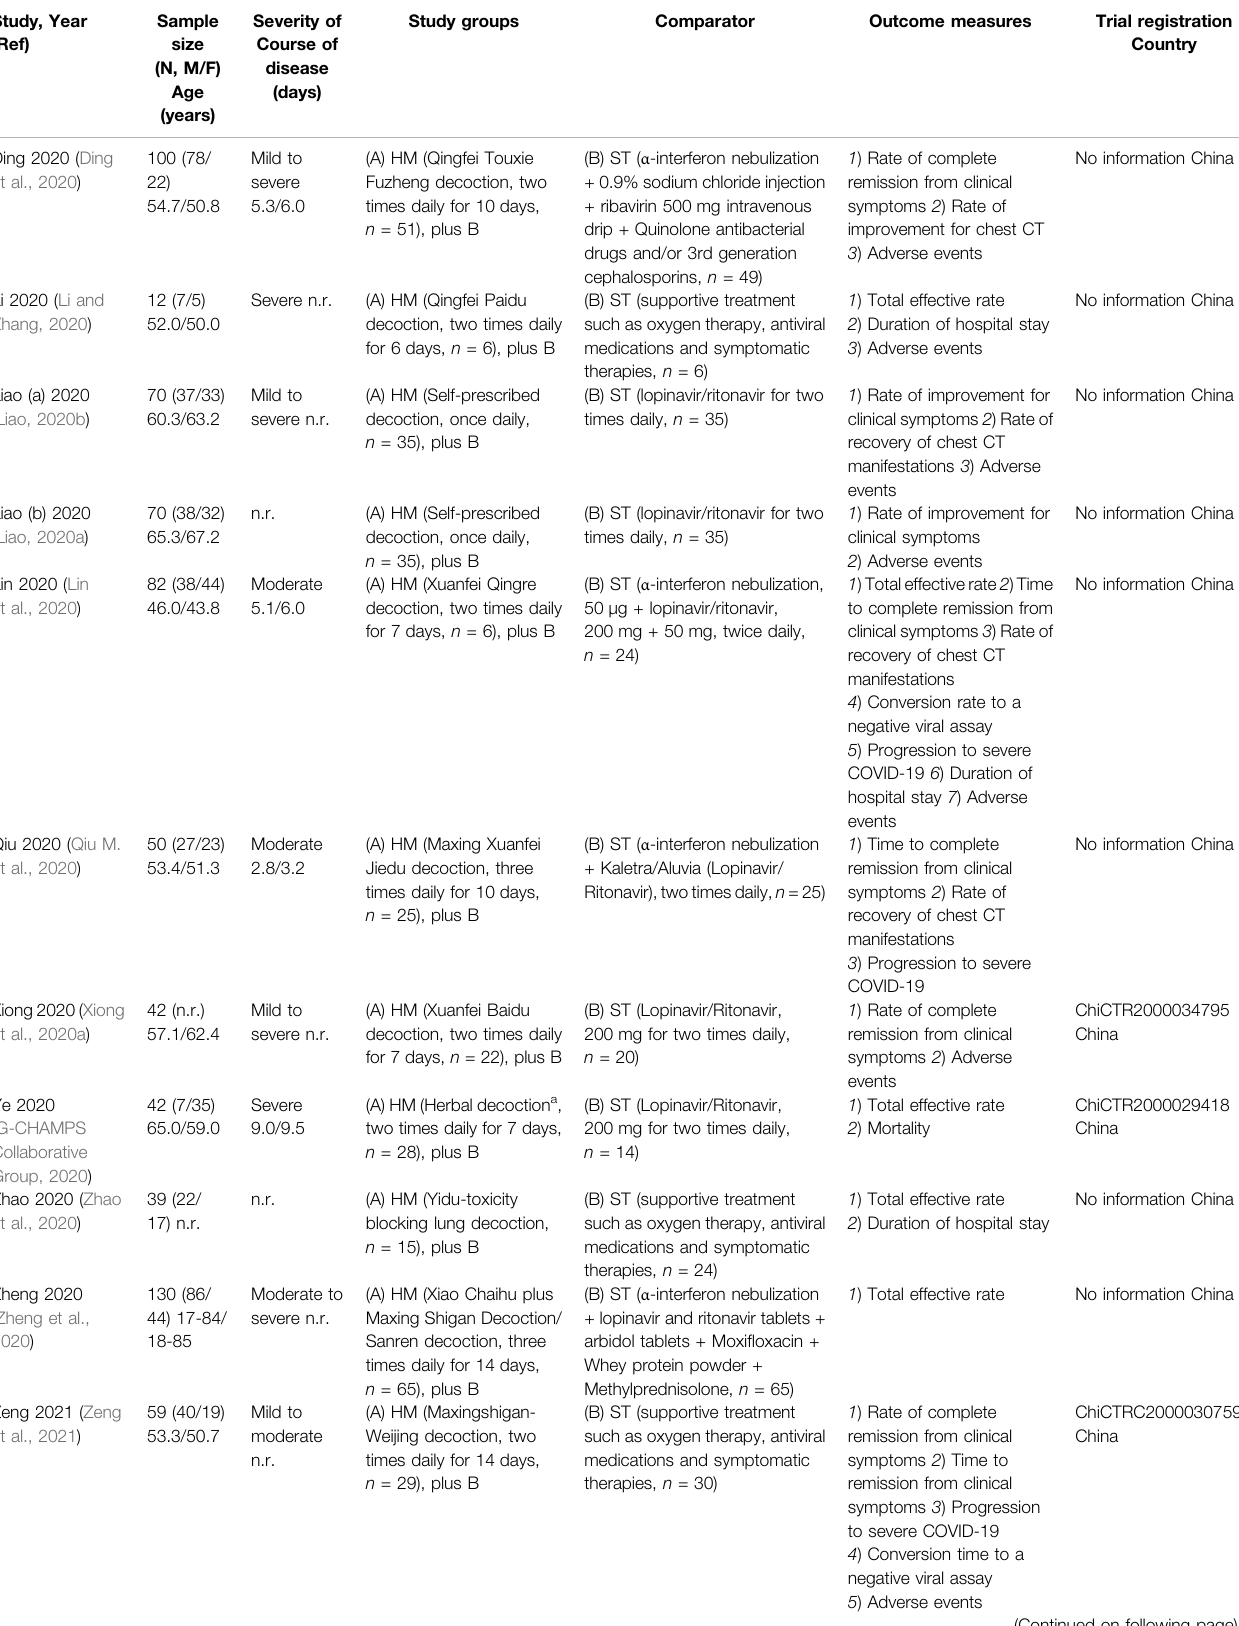
TABLE 1 | Study characteristics of trials conducted with herbal medicine for the treatment of